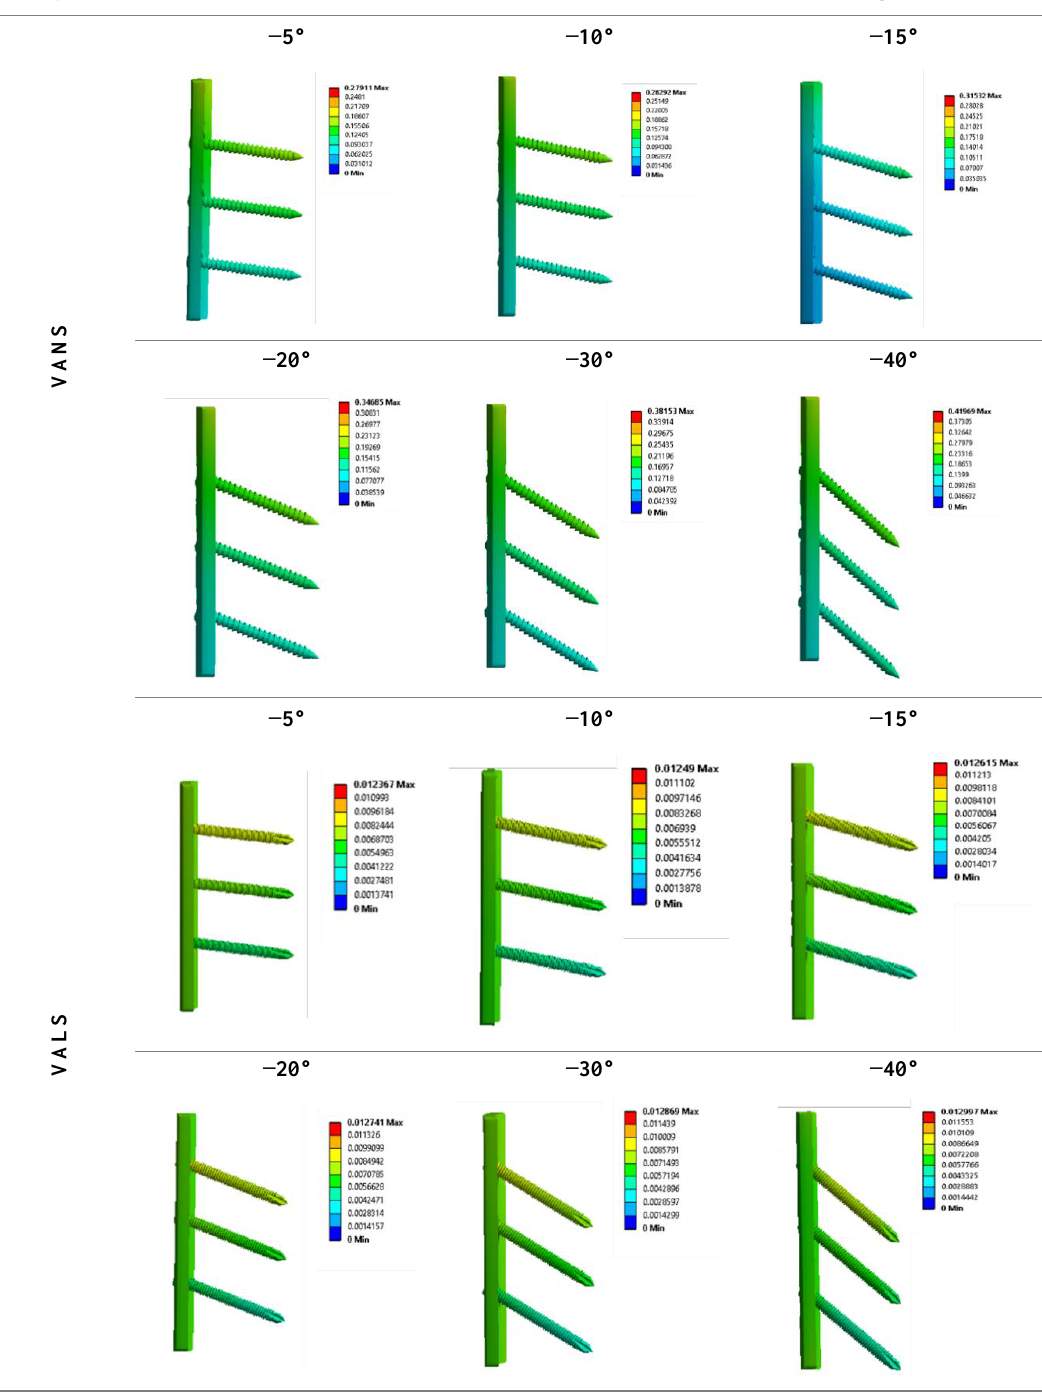
Figure A18. Total displacement (mm) of the PHILOS construct with VALS and VANS at downward angles (5°, 10°, 15°, 20°, 30°, 40°) to the neutral axis.